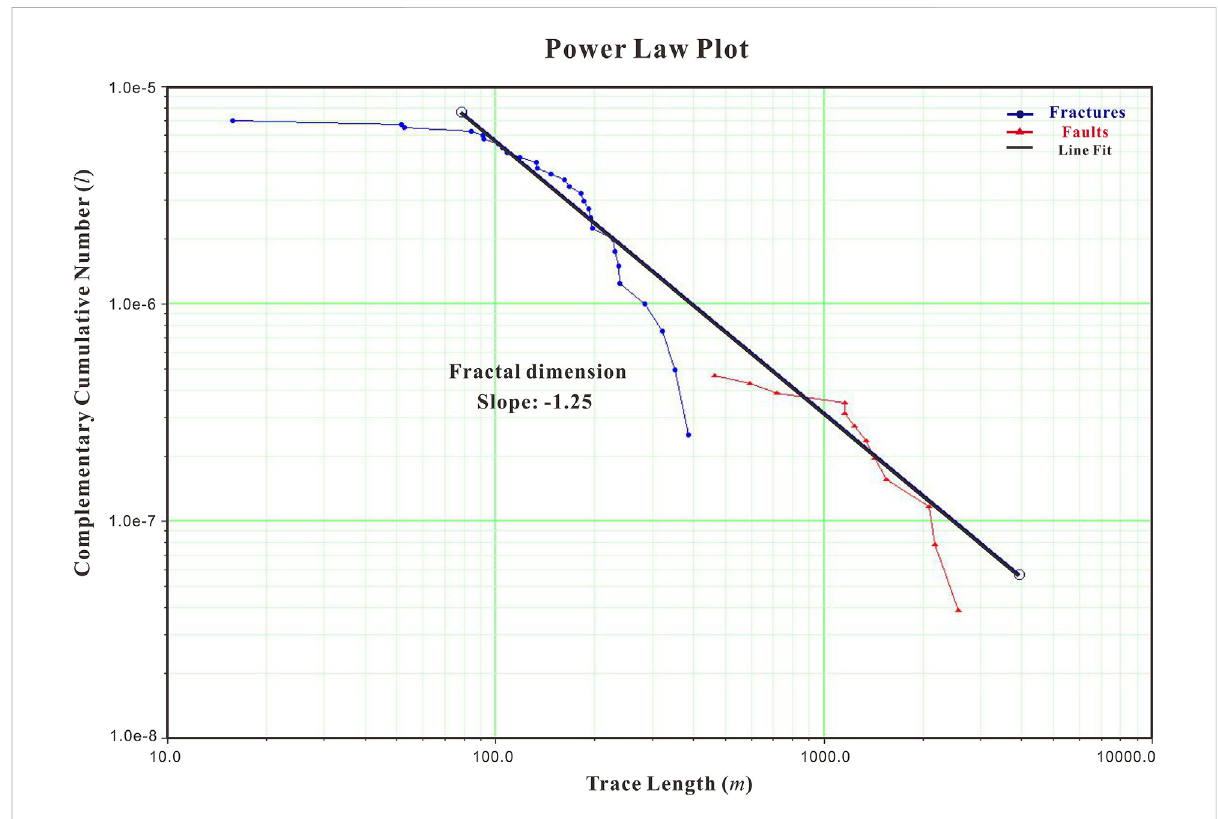
FIGURE 8 Distribution law of fracture system with different scales based on